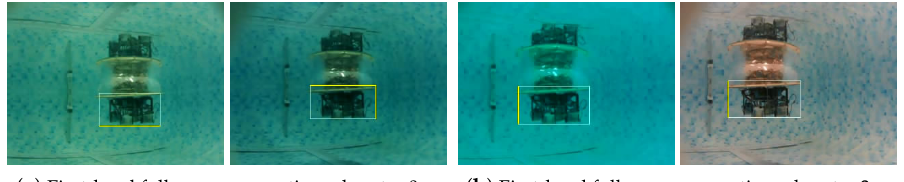
Figure 20. Images of global perspective and follower perspective of the three-robot “V-type escort” formation experiment.